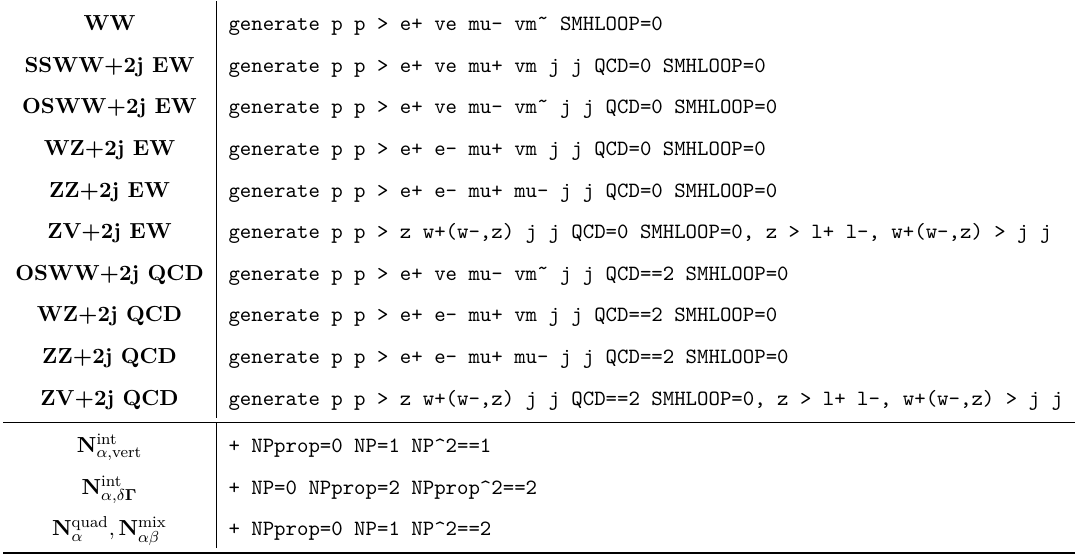
Table 2 . Upper block: Madgraph5_aMC@NLO strings used to generate the SM components of the processes of interest. Where relevant, the charged conjugate processes were included in the generation. The charged lepton shortcut l- stands for electron or muon. Lower block: strings added to the SM ones in order to generate the three main classes of SMEFT corrections, following the SMEFTsim